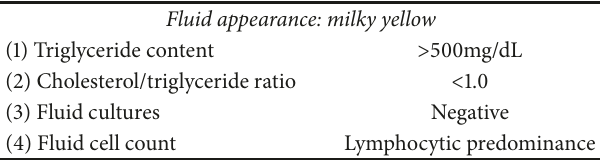
Table 1: Diagnostic criteria of chylous fluid analysis. Fluid appearance: milky